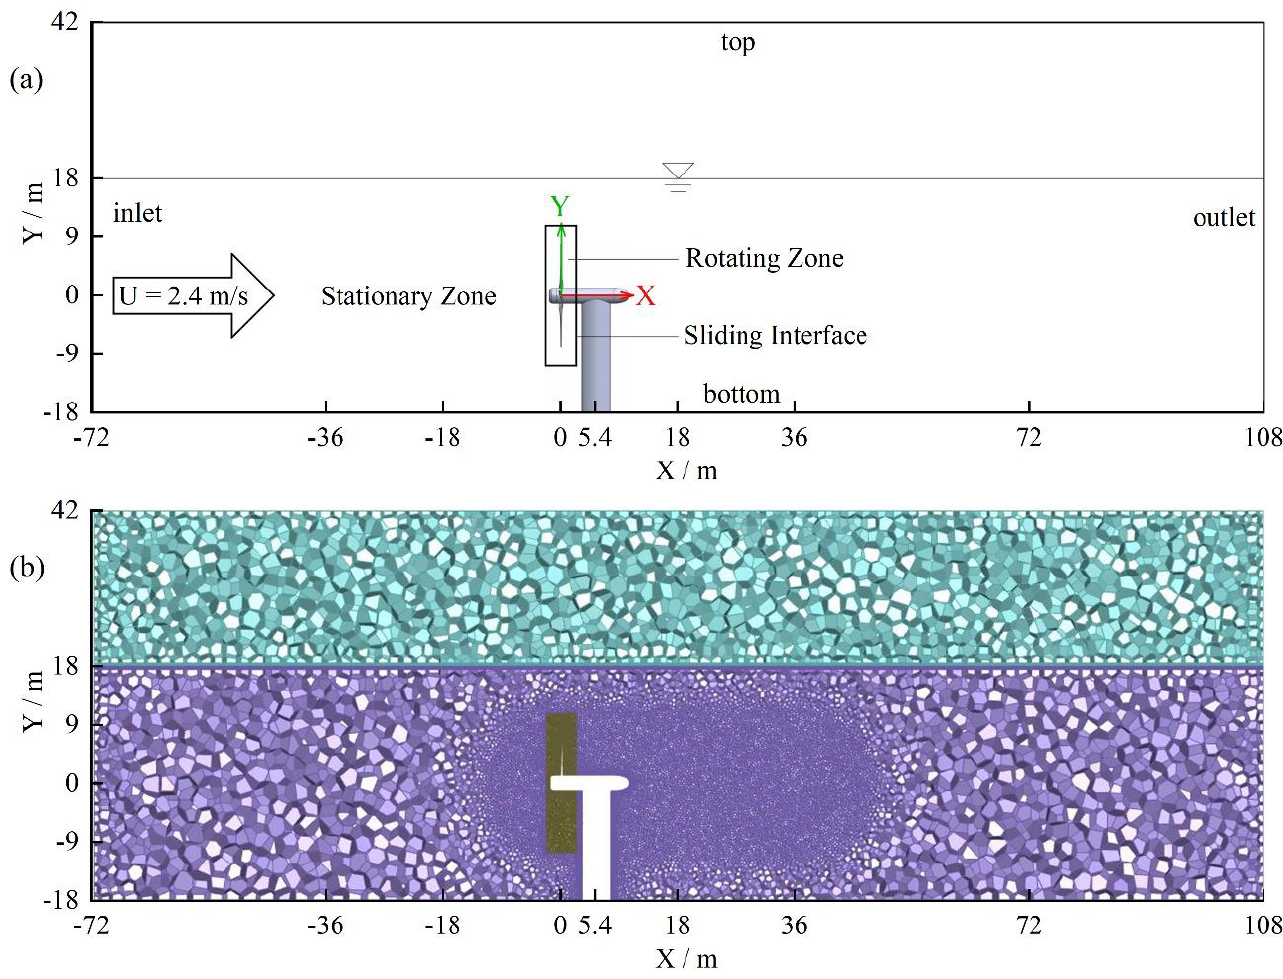
gradient near the top, in which total pressure is set to 0. The bottom and side walls are set as symmetry boundaries. All parts of the BHATT are simplified as a smooth wall.